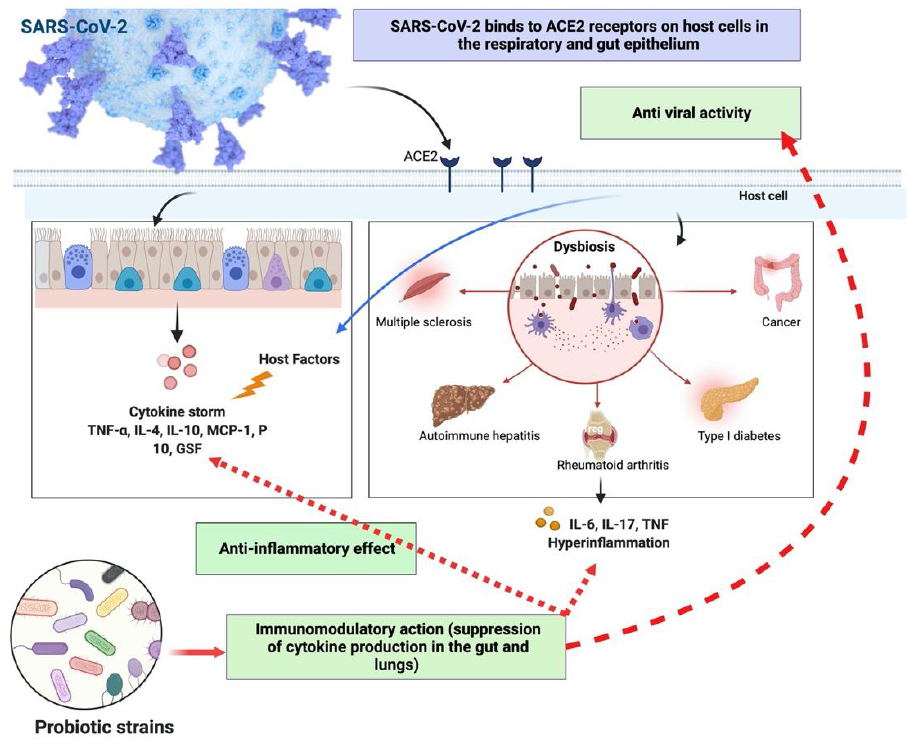
Figure 3. The possible role of probiotics in SARS-CoV-2 infection.